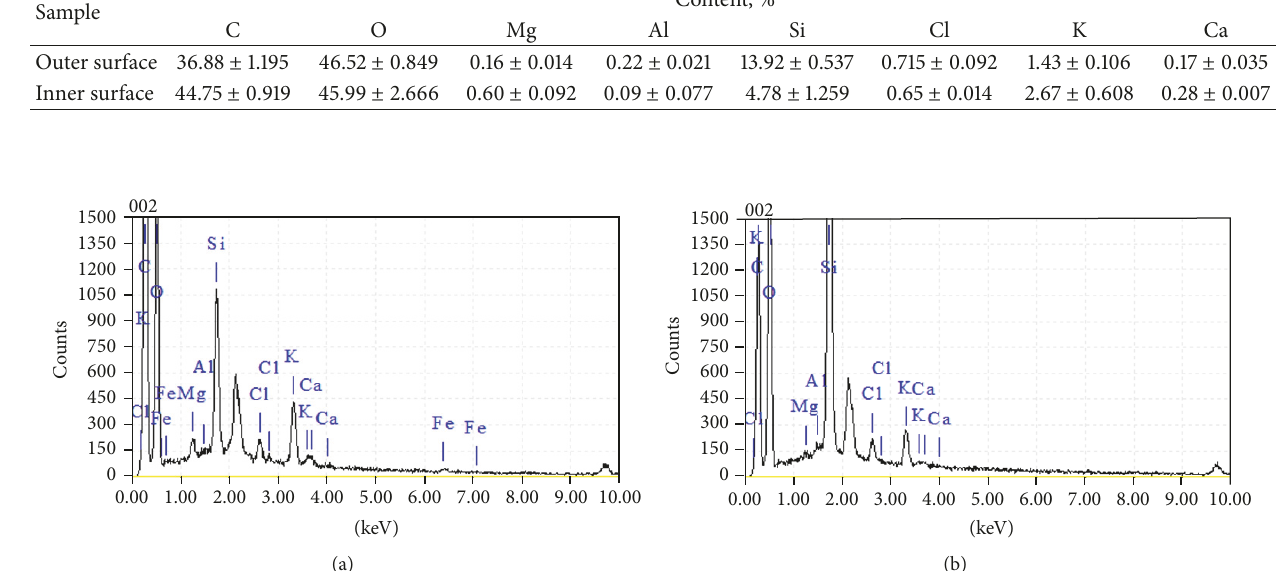
Figure 1: EDX spectra of (a) inner and (b) outer surface of Vietnam’s rice